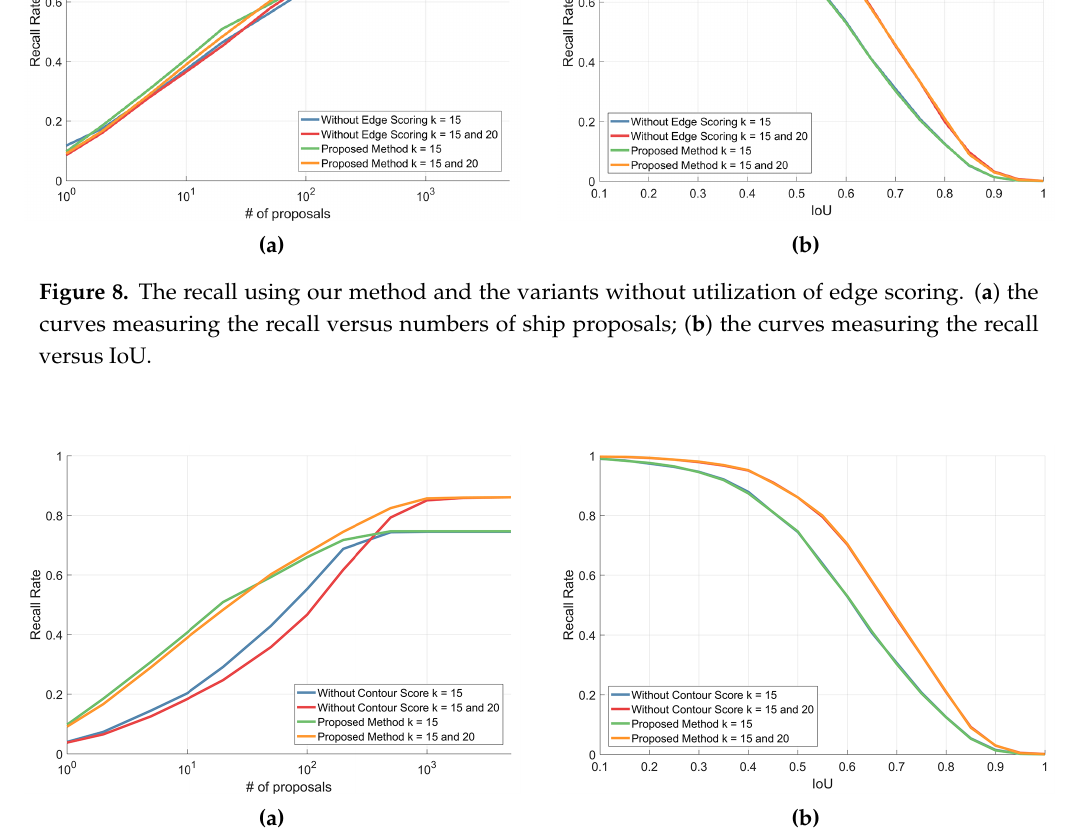
Figure 9. The recall using our method and the variants without utilization of contour scoring. ( a ) the curves measuring the recall versus numbers of ship proposals; ( b ) the curves measuring the recall versus